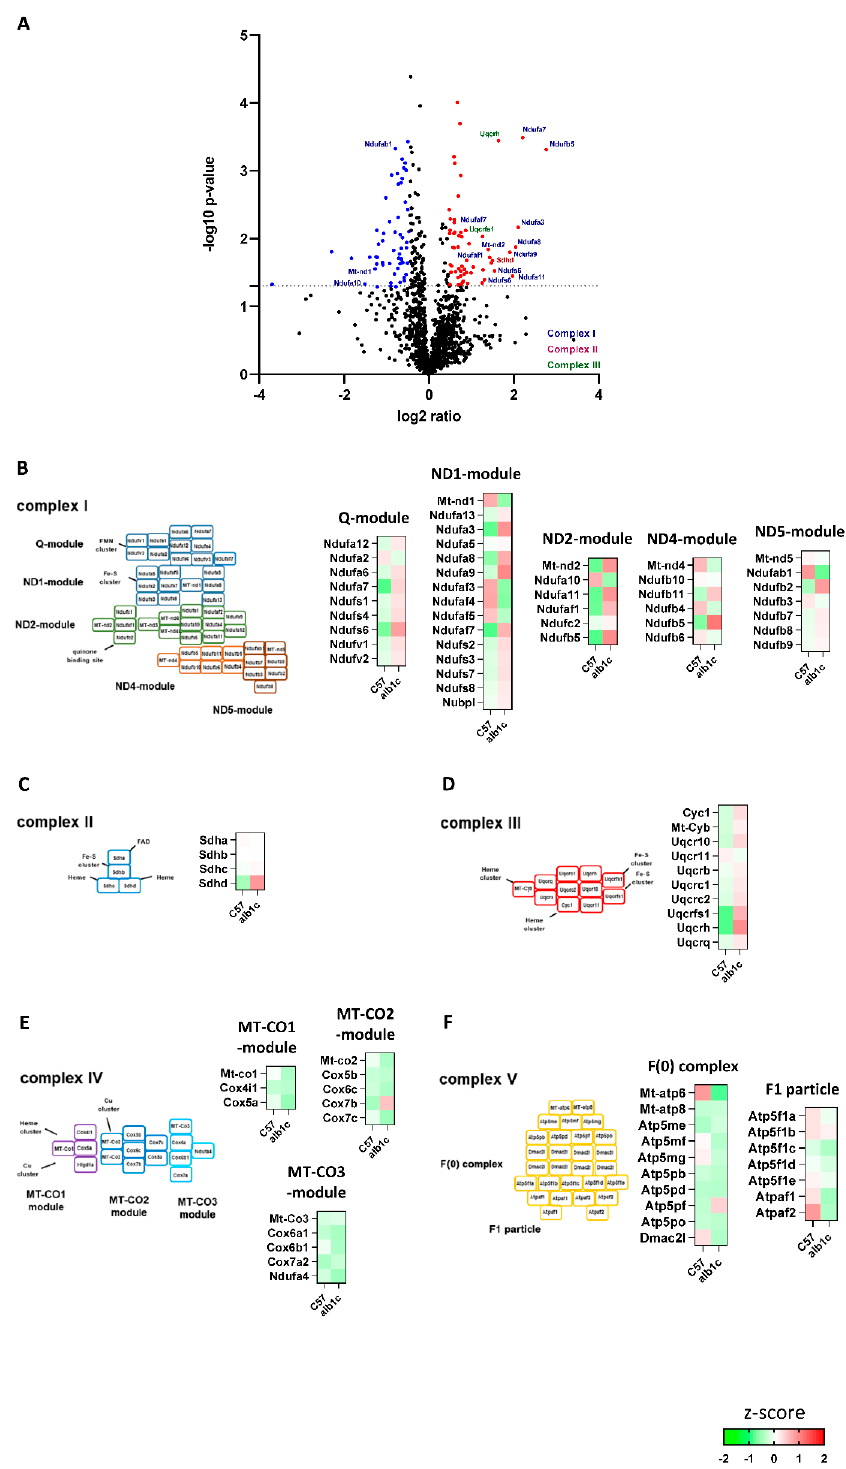
Figure 3. Regulated mitochondrial proteins in early stage of MAFLD. ( A ) The log2 fold changes of protein abundance in fractions of enriched mitochondria from alb-SREBP-1c vs. C57Bl6 liver tissue (n = 6 animals per condition). 1424 proteins were detected. Upregulated (red; n = 48) or downregulated proteins (blue; n = 40) were determined by Student’s t -test ( p > 0.05) with at least 1.5-fold regulation. ( B – F ) Z-score analyses of protein abundance for individual complex I, II, III, IV, and V subunits: Red identifies upregulation of proteins, and green identifies downregulation. White identifies no